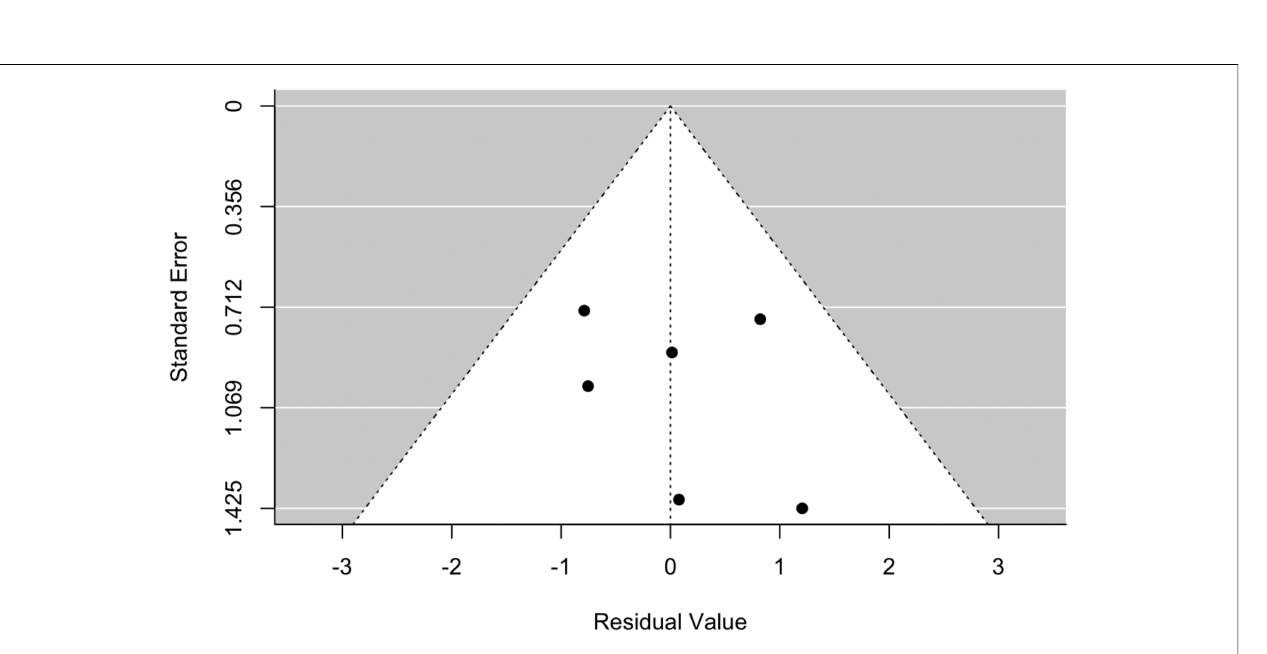
FIGURE 3 Funnel plot for meta-analysis and meta-regression, accounting for the type of effect measure, for the relative risk of developing CKD in patients with VUPs. CKD, chronic kidney